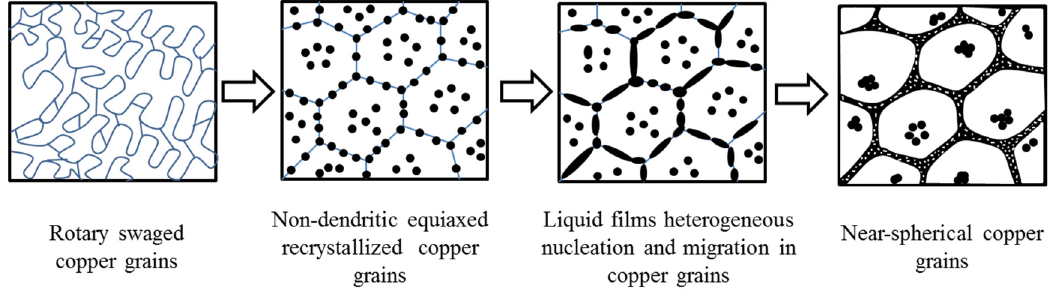
Figure 7. Schematic diagram of microstructure evolution of the rotary swaged alloys during RSSIMA.